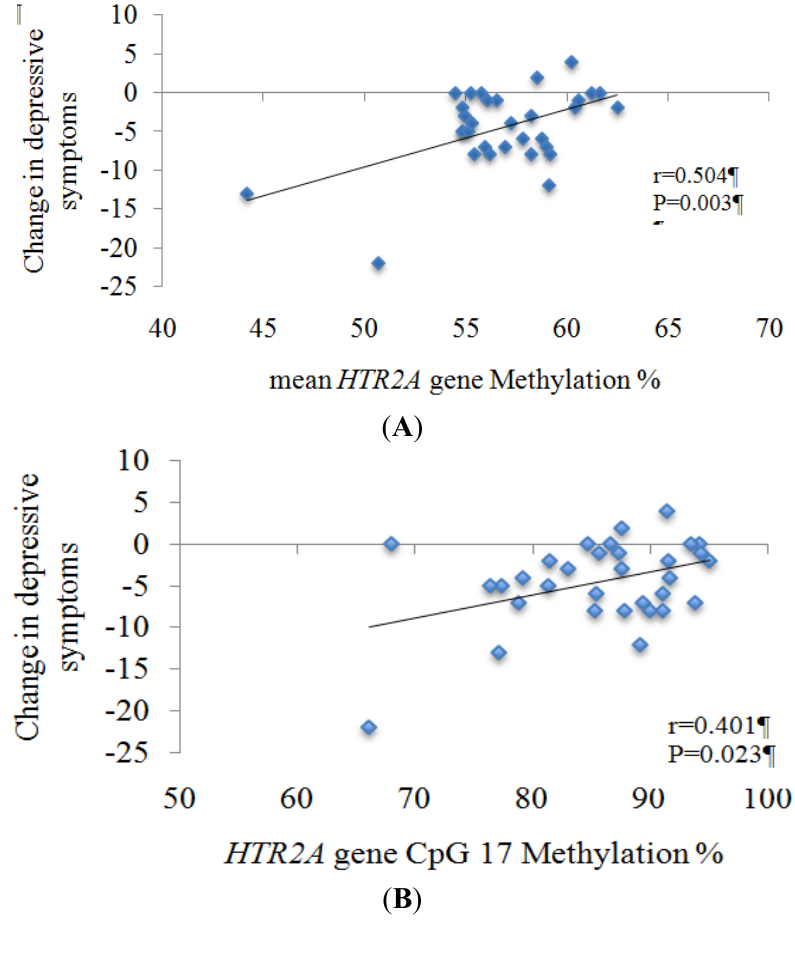
Figure 4. Association of the decrease (six-month baseline) in depressive symptoms with baseline ( A ) mean HTR2A methylation; ( B ) methylation levels of HTR2A CpG17 site; in the whole-study sample n = 32. Change = six-month baseline. Abbreviations: HTR2A ; 5-hydroxytryptamine receptor